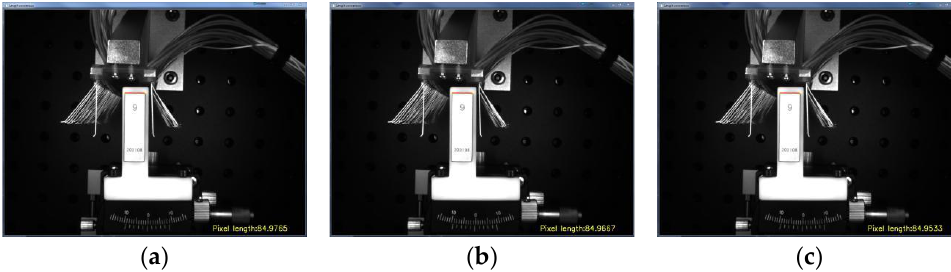
Figure 6. Camera imaging model.